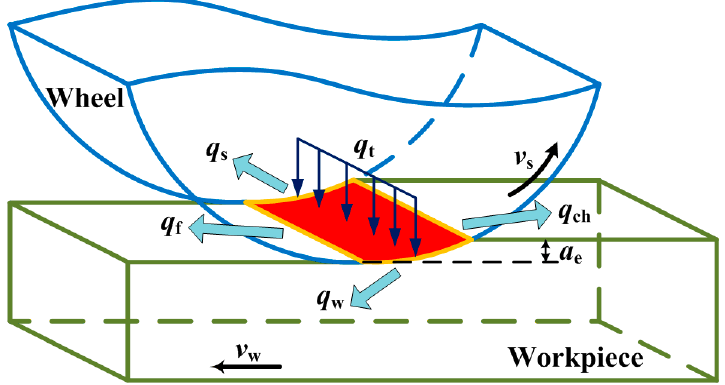
Figure 1. Schematic diagram of grinding heat transfer.